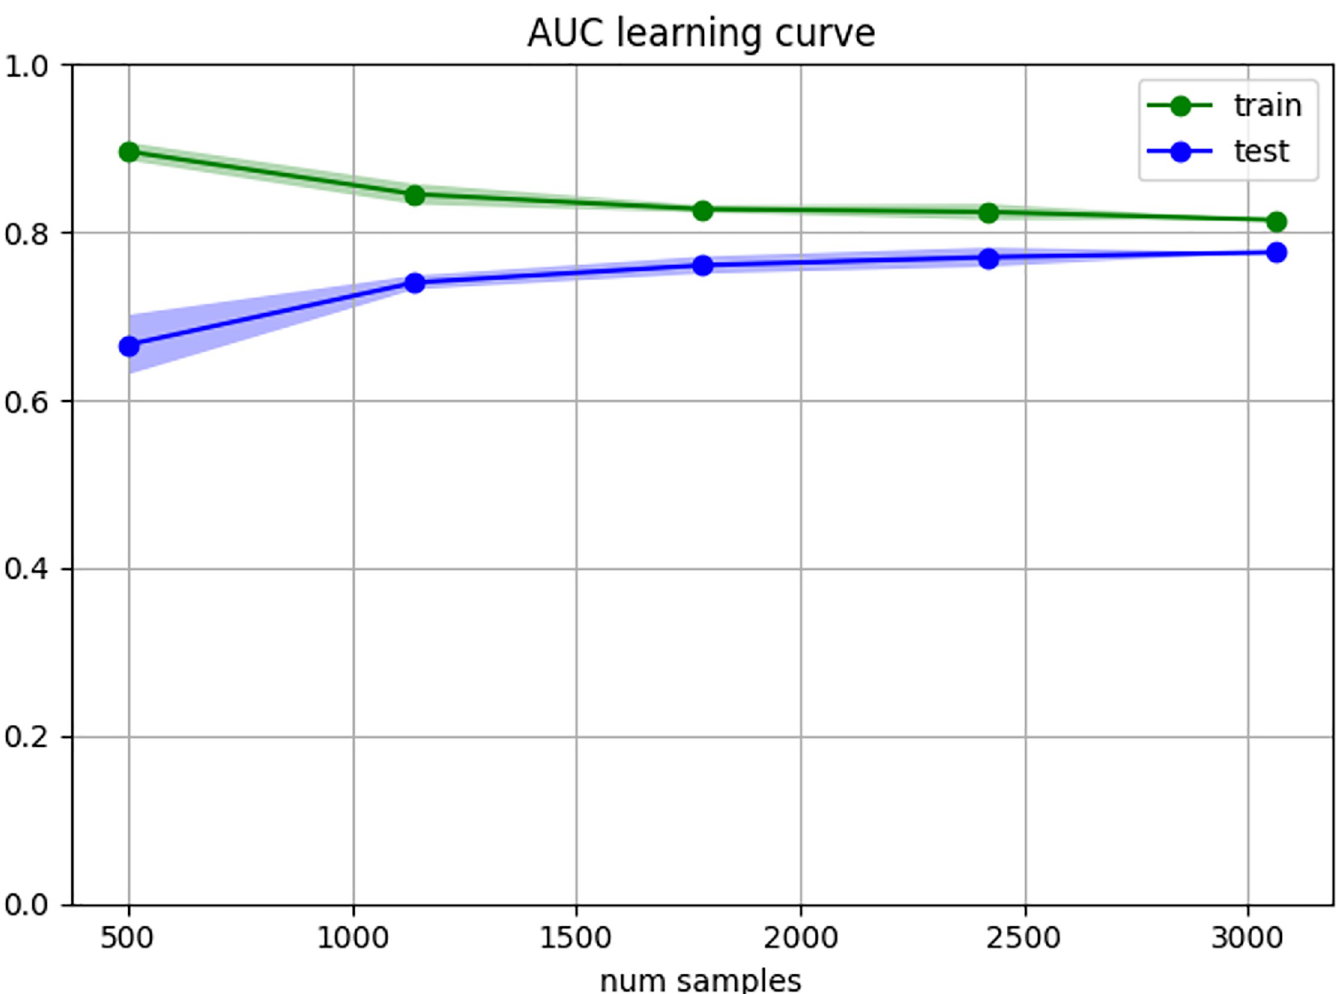
Fig 3. Model performance (learning and stability). The shade colors represent the variance of results created by the K-Fold(4)